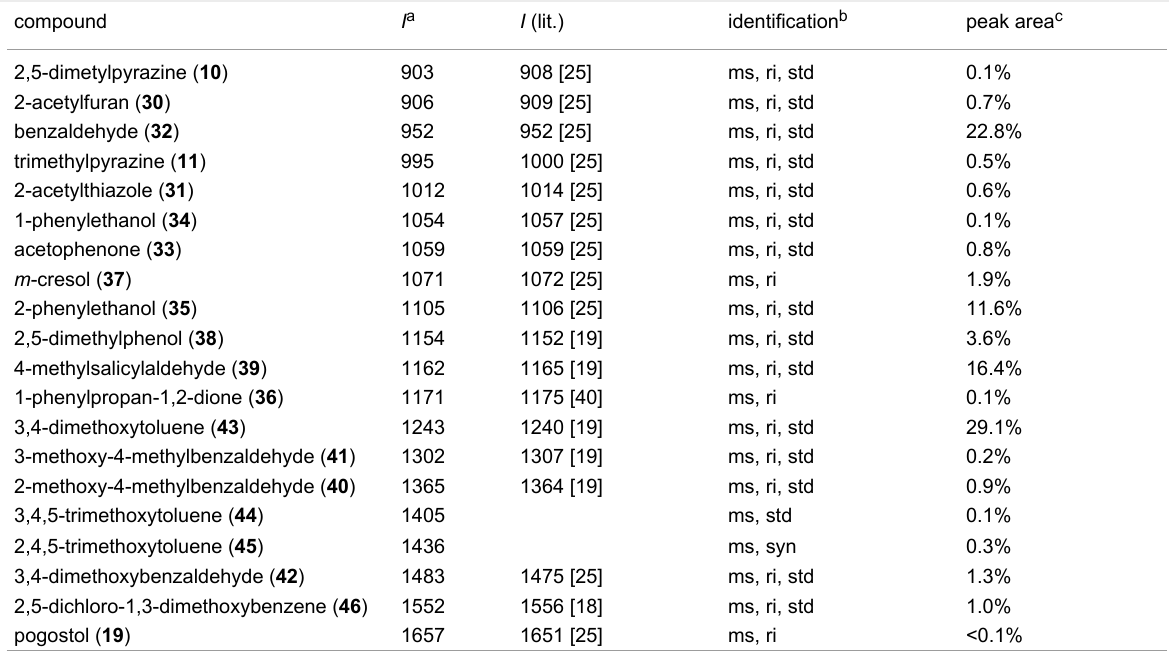
Table 5: Volatiles identified in headspace extract from Hypoxylon macrocarpum STMA